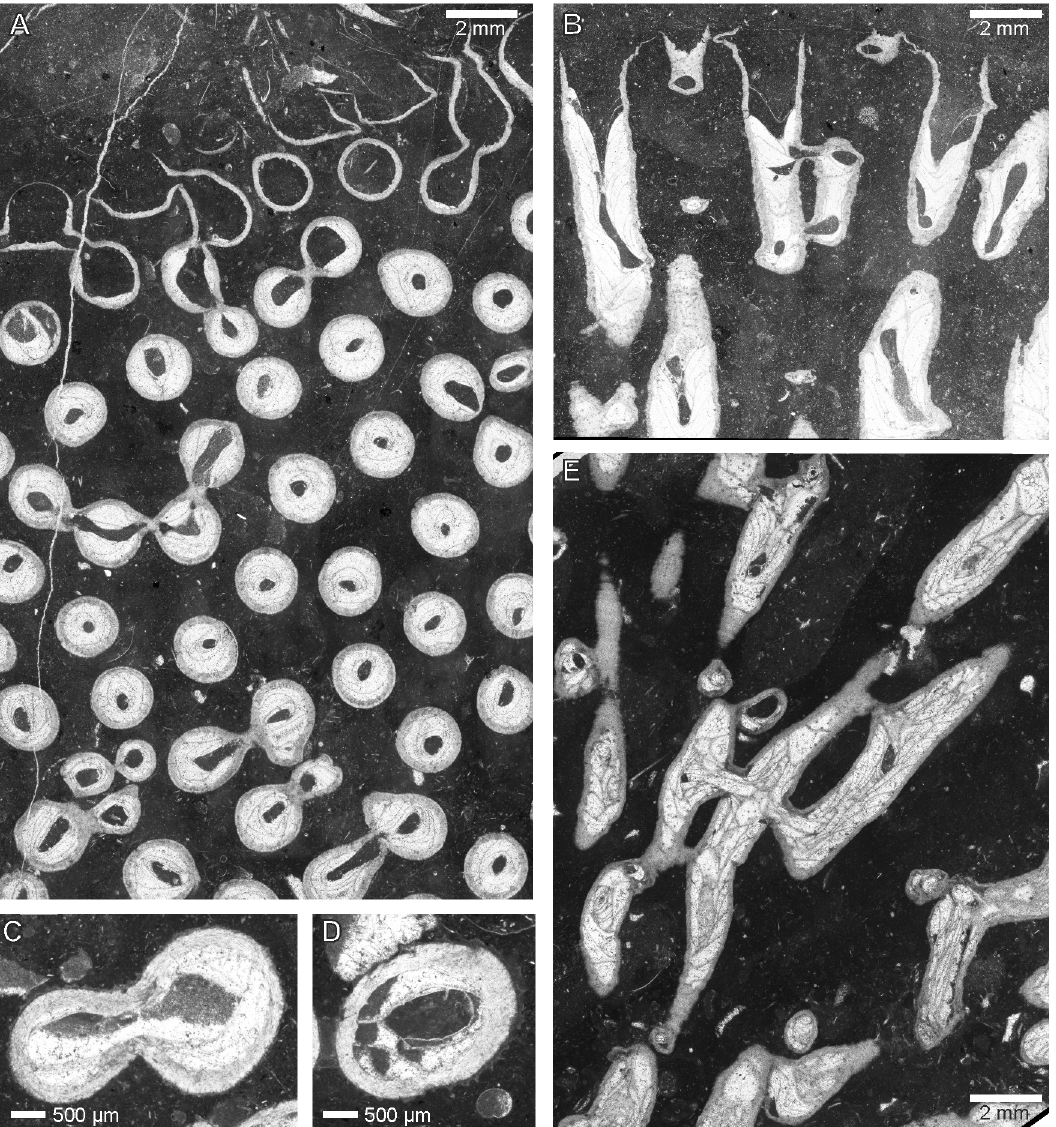
Fig 11. Syringopora kowalensis sp. nov. from Kowala Quarry, lithological set L, Upper Famennian. (A) Transverse section. (B) Longitudinal section. Notice deep calyces. Specimen GIUS 3619 KF 005, holotype. (C) and (D) Details of corallites. Specimen GIUS 3619 KF 008. (E). Longitudinal section. Specimen GIUS 3619 KF